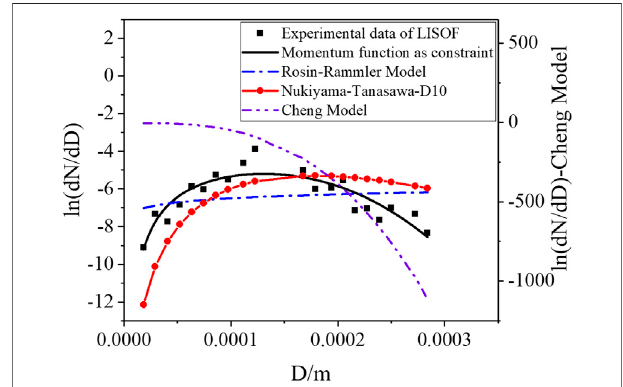
FIGURE 11 | Comparison of Nukiyama-Tanasawa model with D10, Cheng model, Rosin-Rammler model and the proposed sodium spray model with LISOF experimental data.